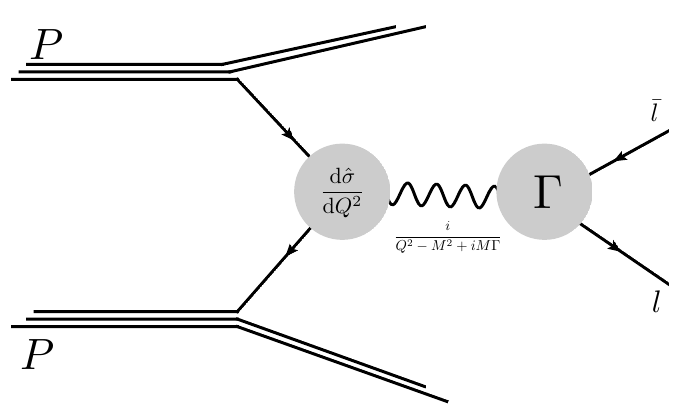
Figure 1 . Schematic depiction of the Drell-Yan process and its factorization into the production probability of a virtual gauge boson and subsequent decay to final-state